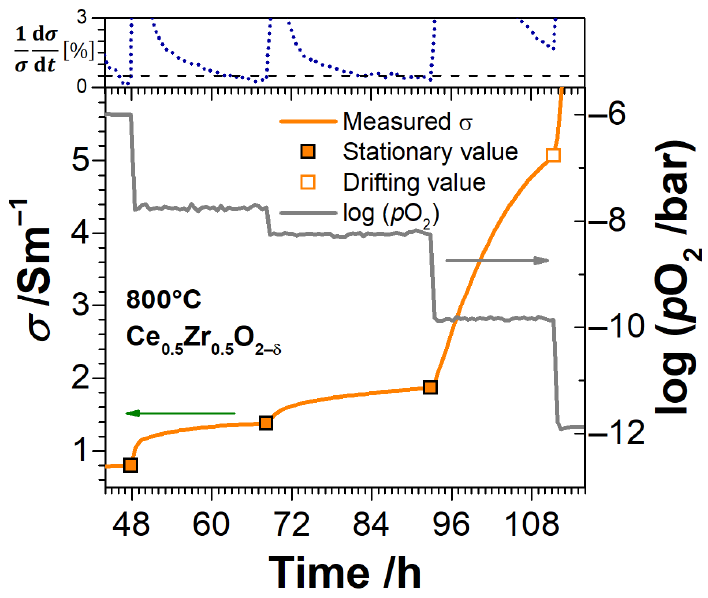
Figure 6. Approach to select stationary and drifting measurement points. In the upper part, the relative change of conductivity with time (blue dotted line) after each log( p O 2 ) set-point is depicted. If the change is less than 0.5% (black dashed line) of the absolute value σ within one hour before the next log( p O 2 ) set-point, the conductivity is considered stationary. Note the differences in log( p O 2 ) step heights (less than − 2) between p O 2 of 10 − 6 bar and 10 − 10 bar. These originate from the corrections applied due to different operating temperatures of the furnace (800 ◦ C) and p O 2 sensor (700 ◦ C), as explained in Section 2.3.